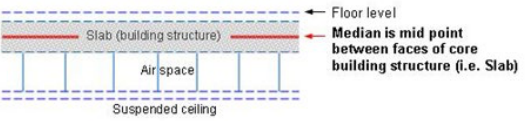
Figure 2. The median boundary in a ceiling